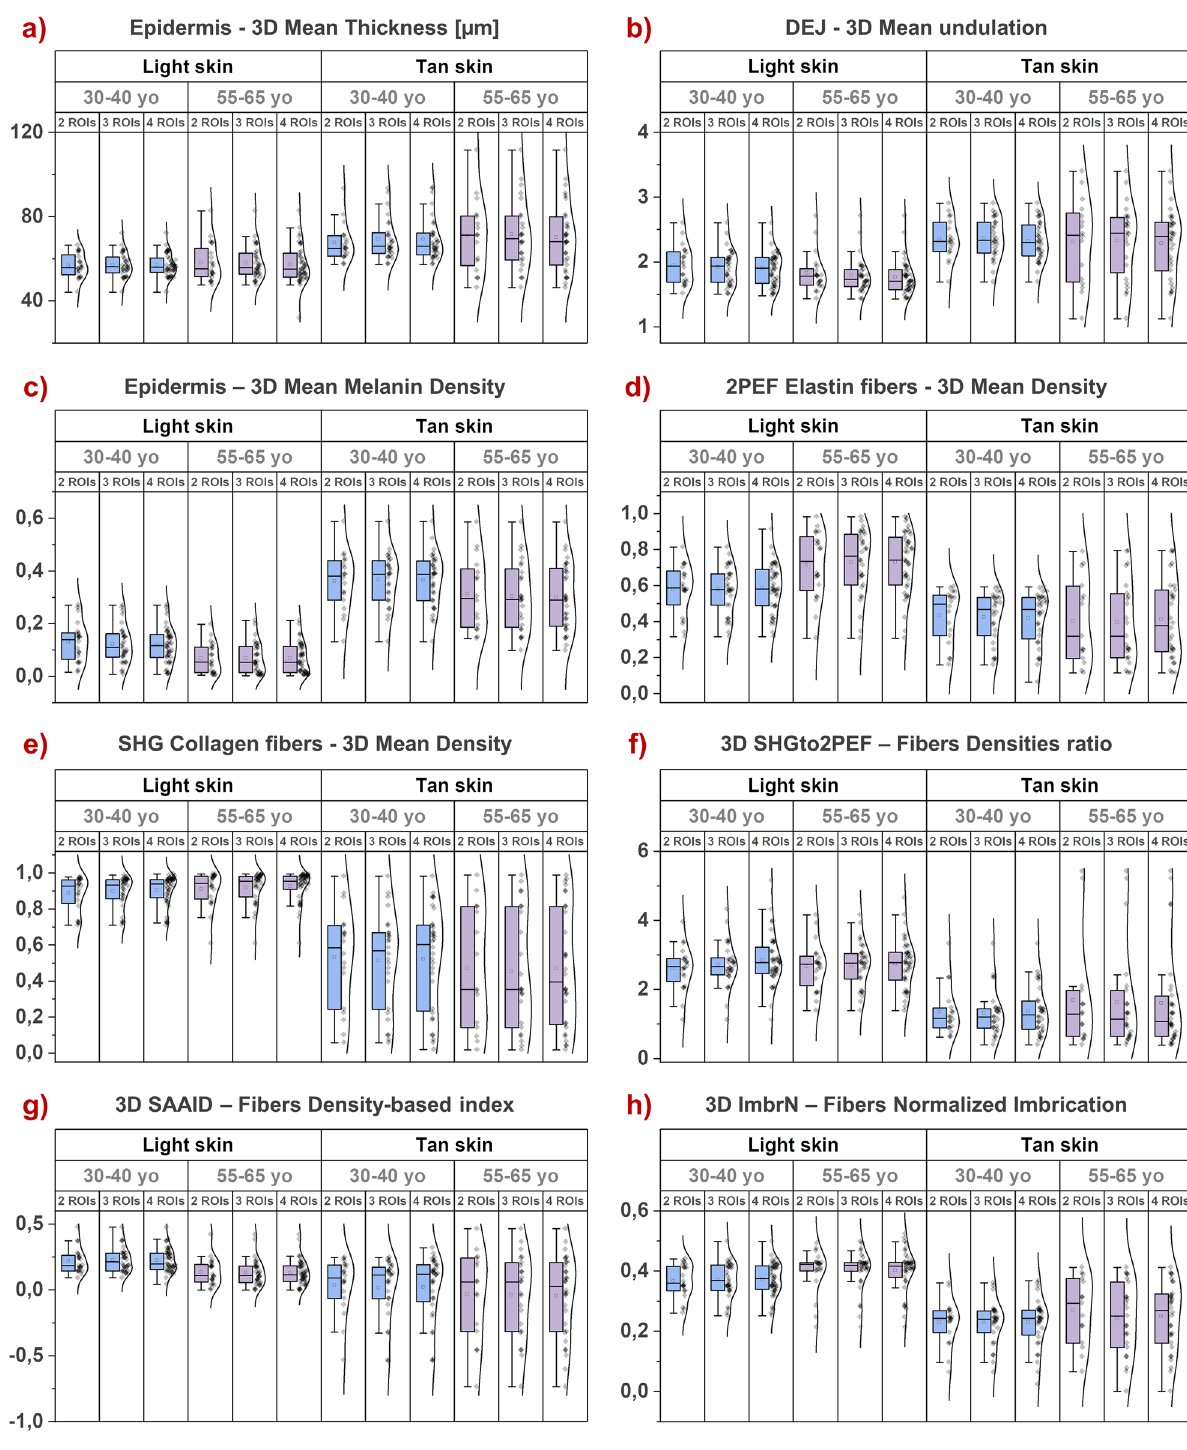
Figure 3. Intrinsic skin variability and robustness of multiphoton 3D quantification parameters for skin assessment. Multiphoton evaluation of ventral forearm skin aging (30–40 vs 55–65 year-old) and color (“light” vs “tan”) differences. ( a ) 3D mean epidermal thickness; ( b ) Mean 3D DEJ undulation; ( c ) 3D Mean melanin density in global epidermis; 3D density of ( d ) 2PEF pixels (corresponding mainly to elastin fibers) and ( e ) SHG pixels (collagen fibers) in a 50-µm thickness normalized dermal sublayer following the DEJ shape. These two parameters are jointly used to calculate ( f ) the 3D SHGto2PEF collagen to elastin fibers densities ratio and ( g ) the 3D SAAID density index (the SHG-to-AF aging index of dermis); ( h ) 3D normalized imbrication (ImbrN) of the elastin and collagen fibers networks within the dermal sublayer. The raw data are expressed as box plots with fences, mean and median (—). All ROIs values and their distribution (dots ( ♦ ) and histogram) are shown on the right side of the boxplot. Overlapping values are highlighted in black ( ♦ ). Each box plot includes the data from 10 volunteers and 2, 3 or respectively 4 ROIs acquired for each volunteer. The statistical analysis results ( p -values) of the homogeneity tests for variances and means between the different ROIs groups are given in Table